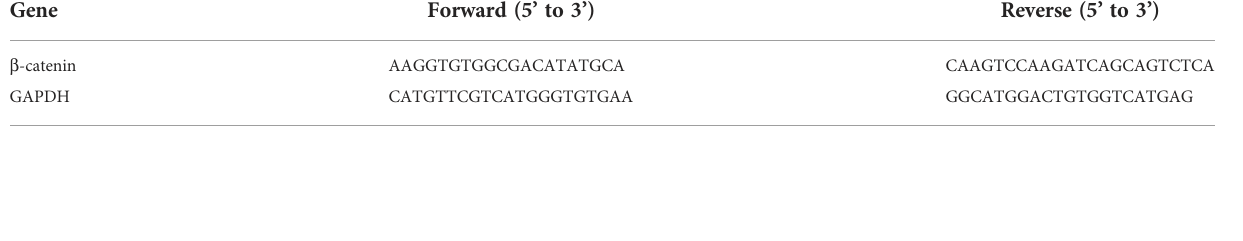
TABLE 1 Oligonucleotide primers used for